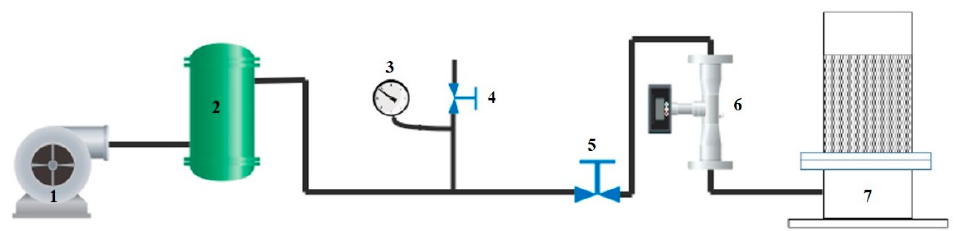
Figure 1. Scheme of the 3D gas–solid fluidized bed experimental system: (1) Blower; (2) Buffer tank; (3) Pressure gauge; (4) Valve; (5) Valve; (6) Flowmeter; (7) Fluidized bed.